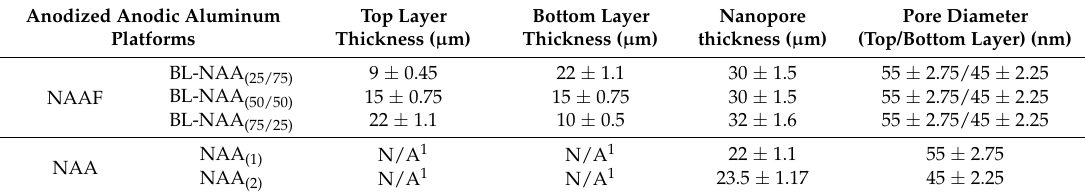
Table 2. Pore dimensions of BL-NAAs and NAAs structures.